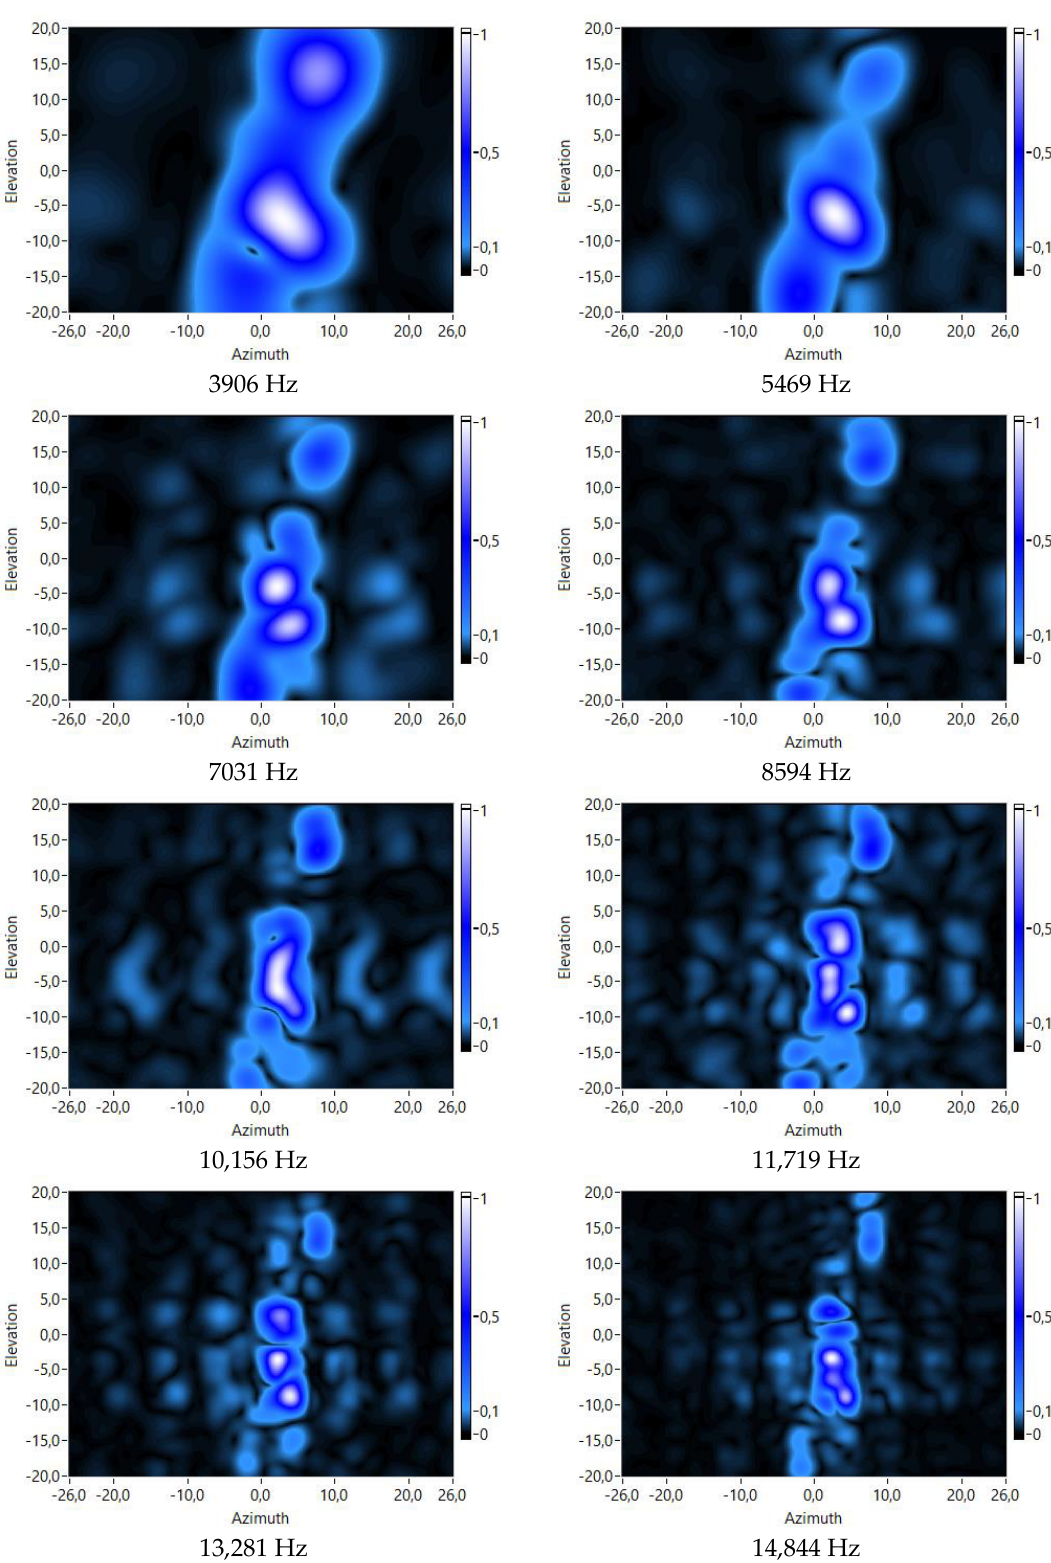
Figure 12. Virtual array responses for several frequencies and a range of 240 cm.